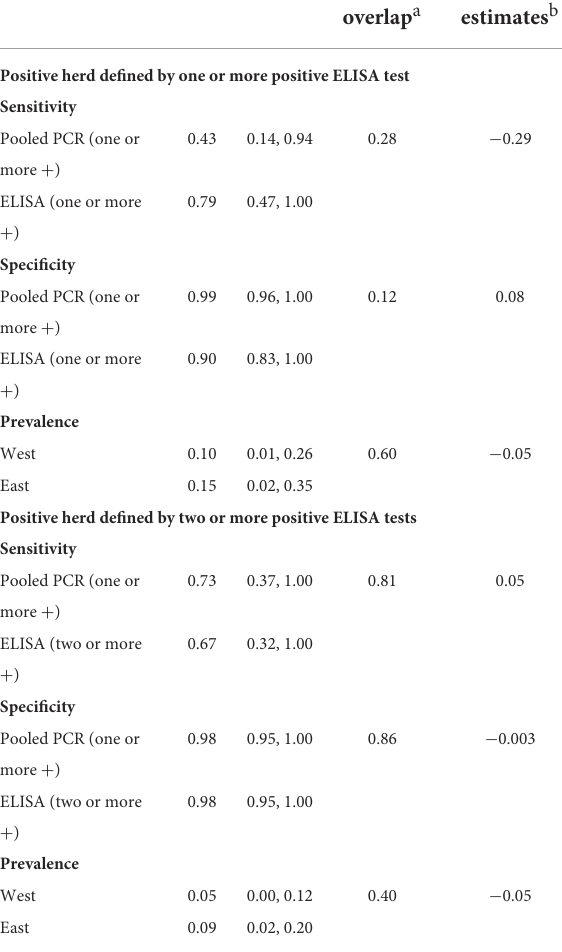
TABLE 8 Sensitivity and specificity estimates for MAP diagnosis in 159 beef cow herds in the absence of a gold standard using two-test, two population Bayesian latent class models with non-informative priors.